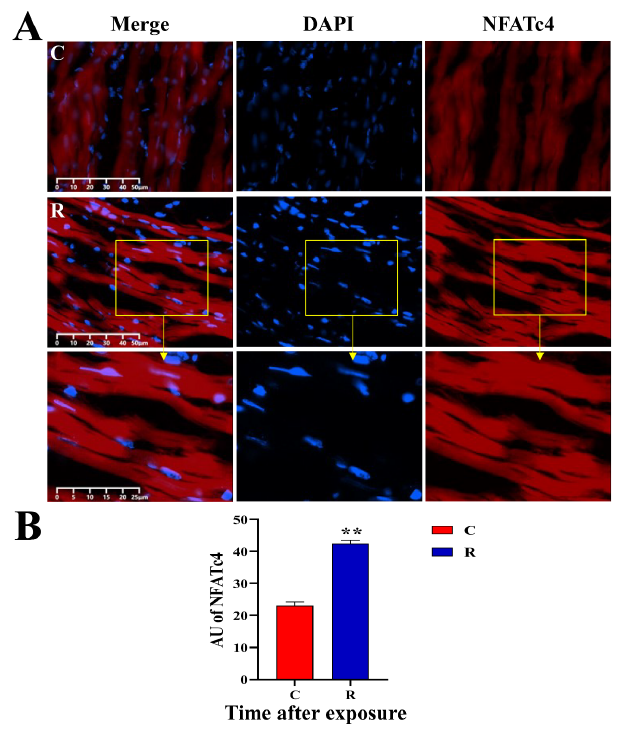
Figure 17. Changes in NFATc4 expression and distribution of rats’ myocardium after S-band radiation. ( A ) Original graph of IF; ( B ) statistical analysis graph of AU. Significance signs were classified according to p -value: ** p < 0.01. The yellow box is the magni fi ed area.